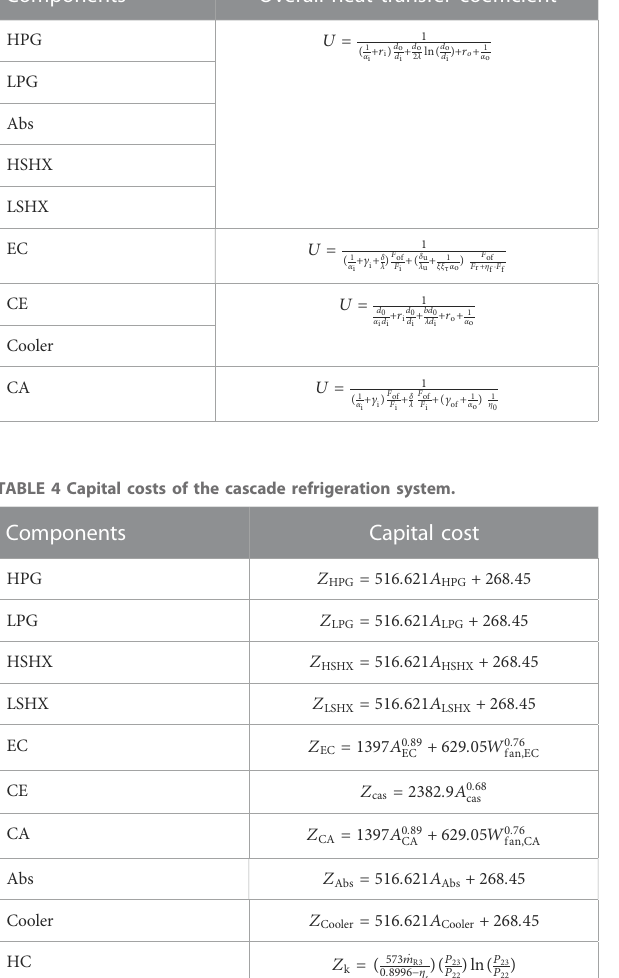
TABLE 3 Overall heat transfer coef fi cient of the cascade refrigeration system. Components